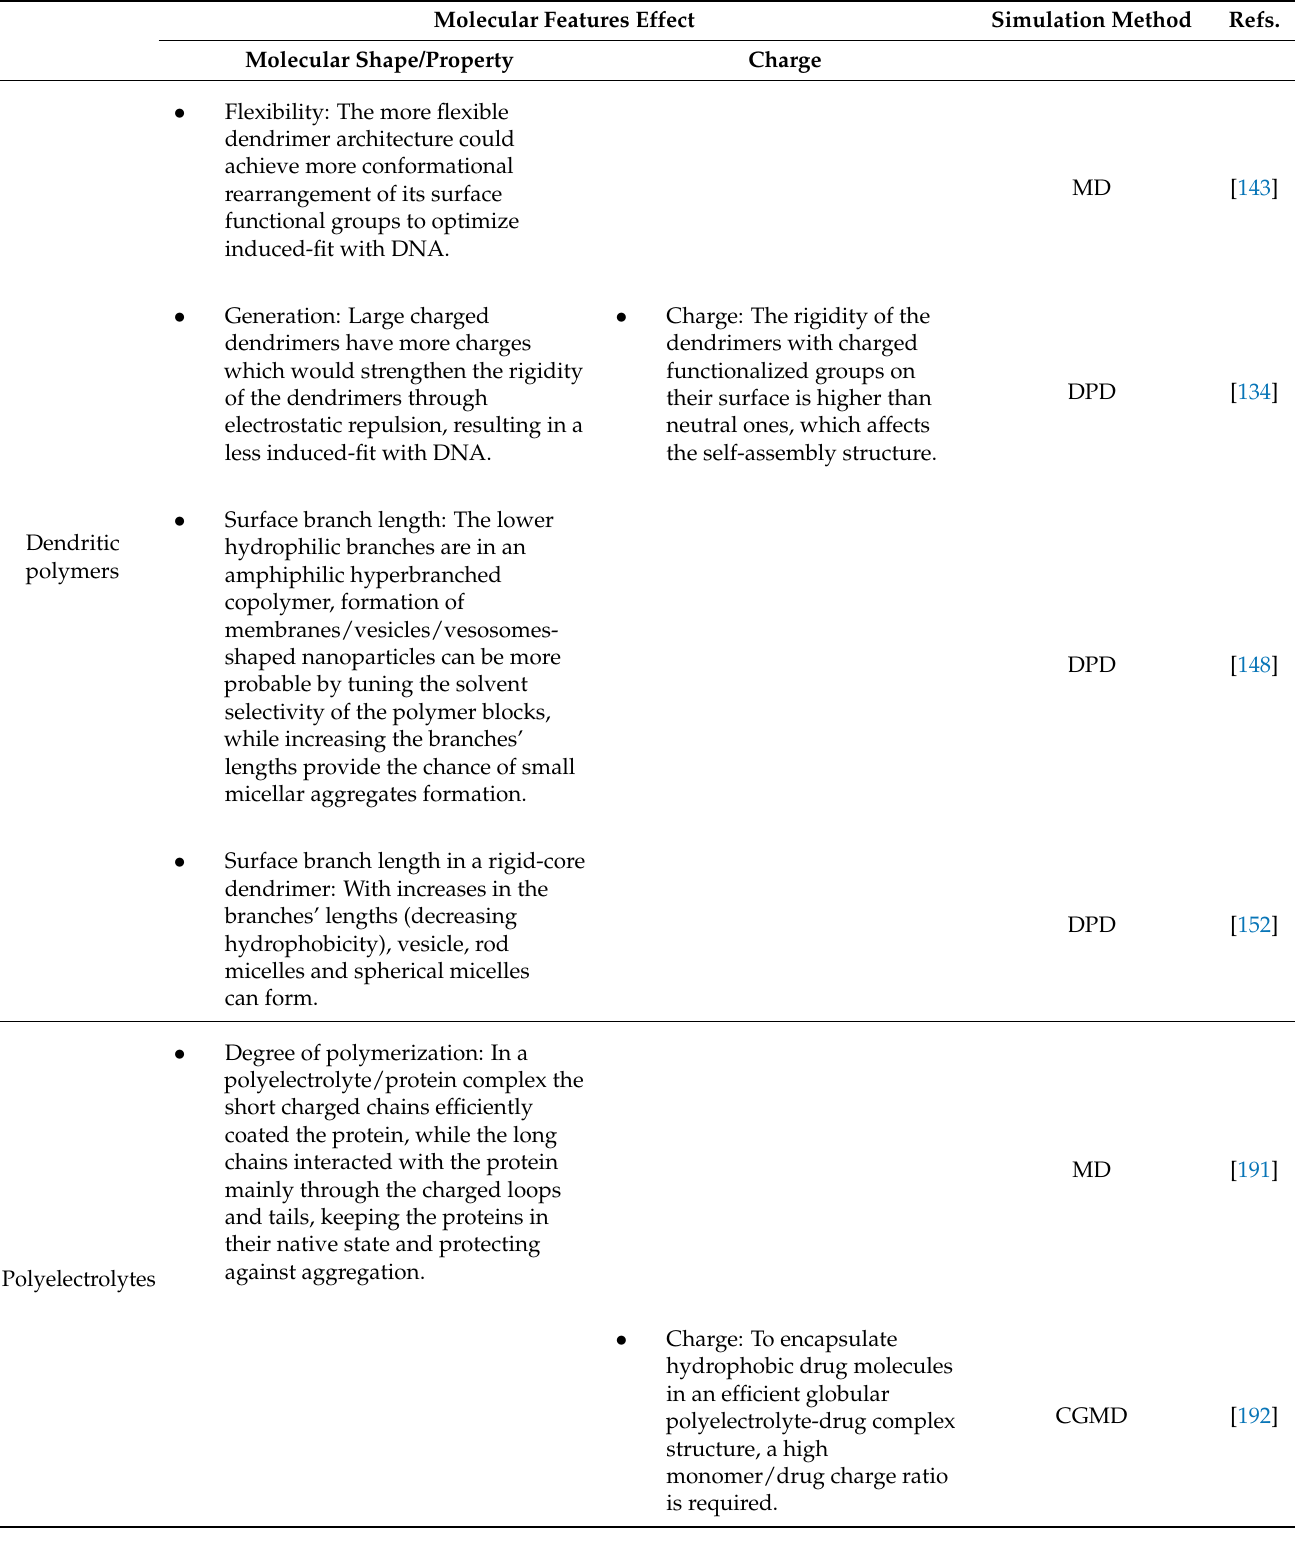
Table 3. Summary of the molecular shape and charge effects on the NPs morphology for drug delivery